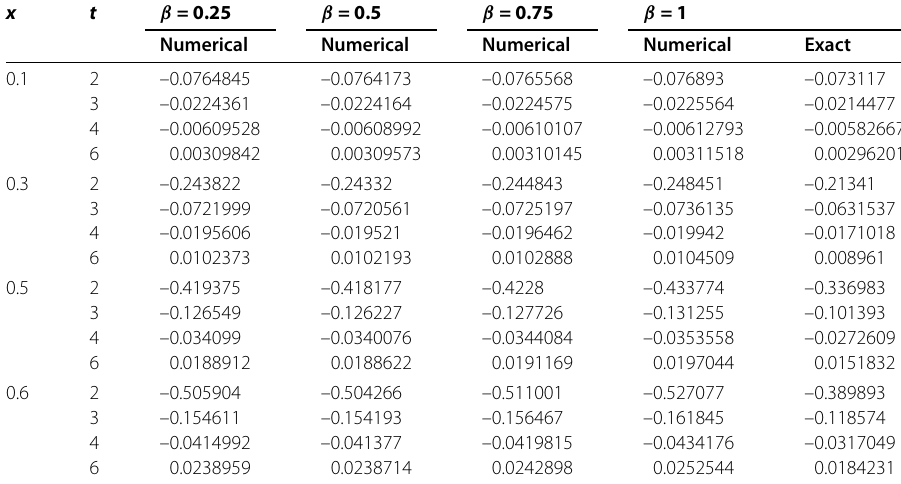
Table 3 The results obtained by the FRDTM for different values of β for Example 4.2